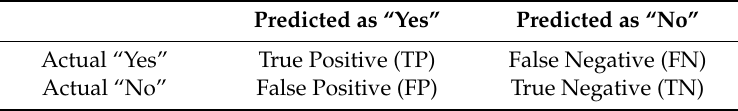
Table 3. Di ff erent outcomes of two-class prediction.